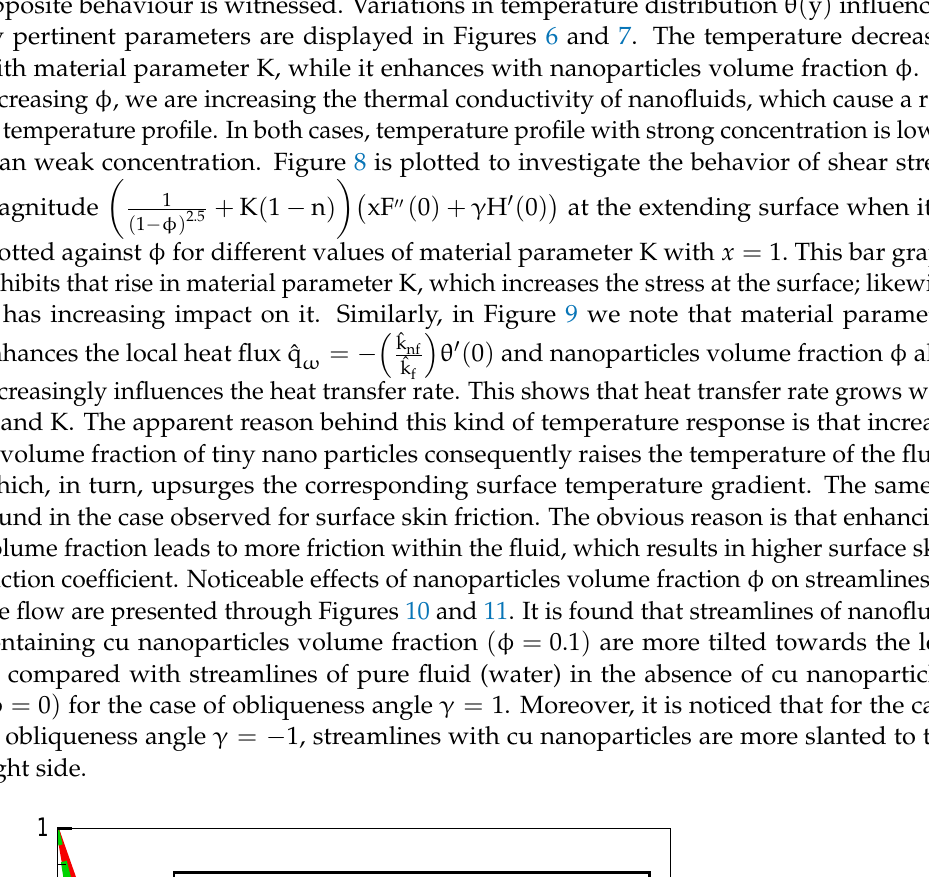
Figure 3. 𝐅 (cid:4593) (𝐲) for volume fraction of nanoparticles 𝛟 .